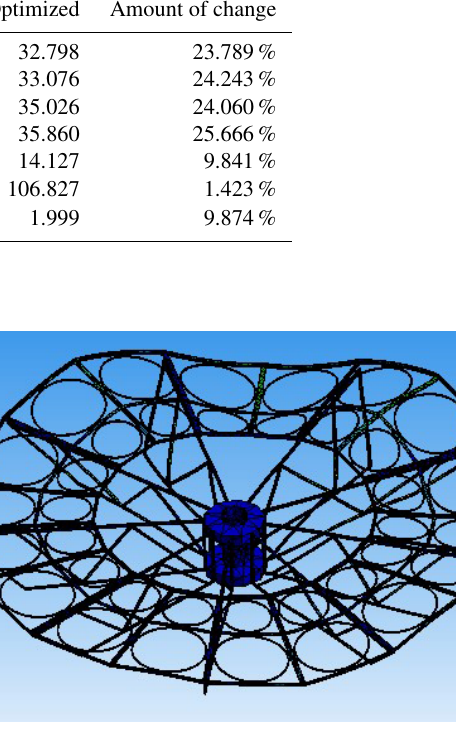
Figure 21. The first-order mode shape of the optimized free vibra- tion.